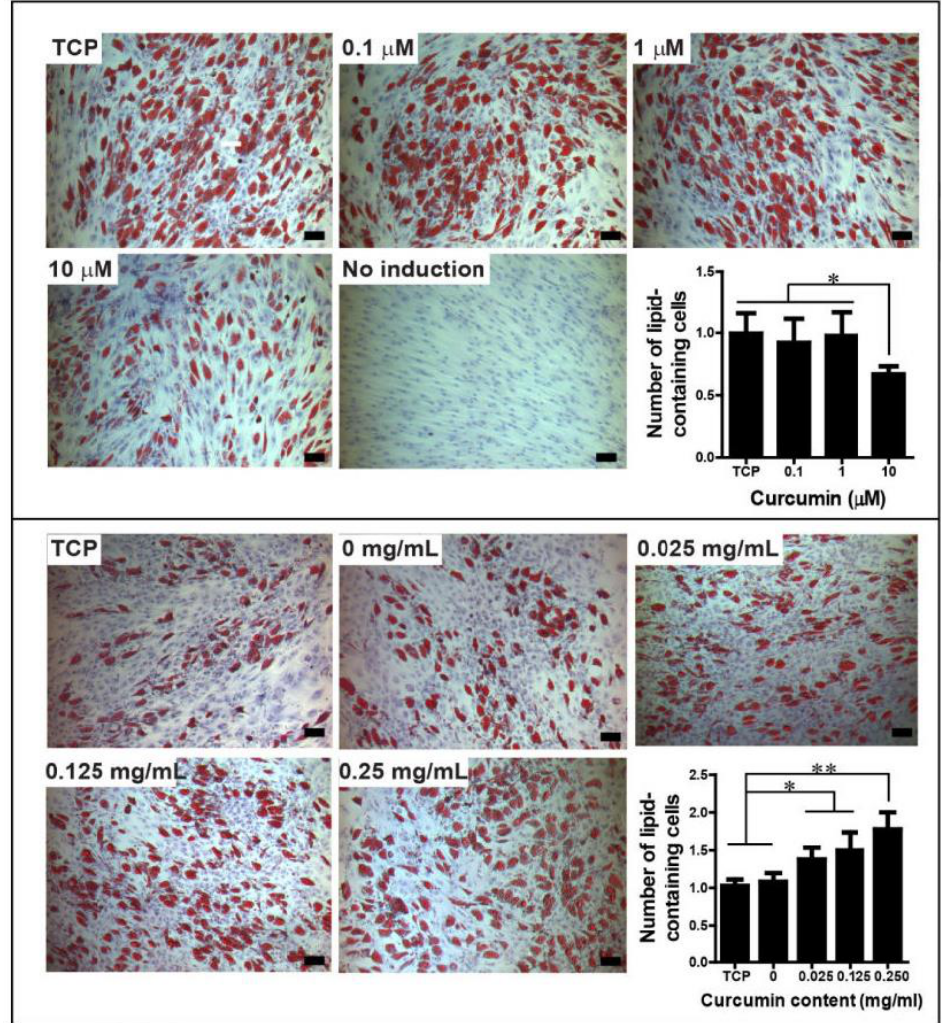
Figure 5. Human bone marrow-derived mesenchymal stem cells (hBMSC) adipogenic di ff erentiation by oil red O staining. Upper panel, hBMSCs cultured in free curcumin-containing medium, day 14; Lower panel, hBMSCs cultured on curcumin-loaded silk hydrogel films, day 14. The number of lipid-containing cells was normalized to TCP control, N = 4–7. *indicates significant di ff erence ( p < 0.05); ** indicates very significant di ff erence ( p < 0.005). Scale bar, 100 µ m. The experiment was repeated twice with similar results. TCP: tissue culture plastic. Adopted with permission from Li et al. with license number of 4595961075431